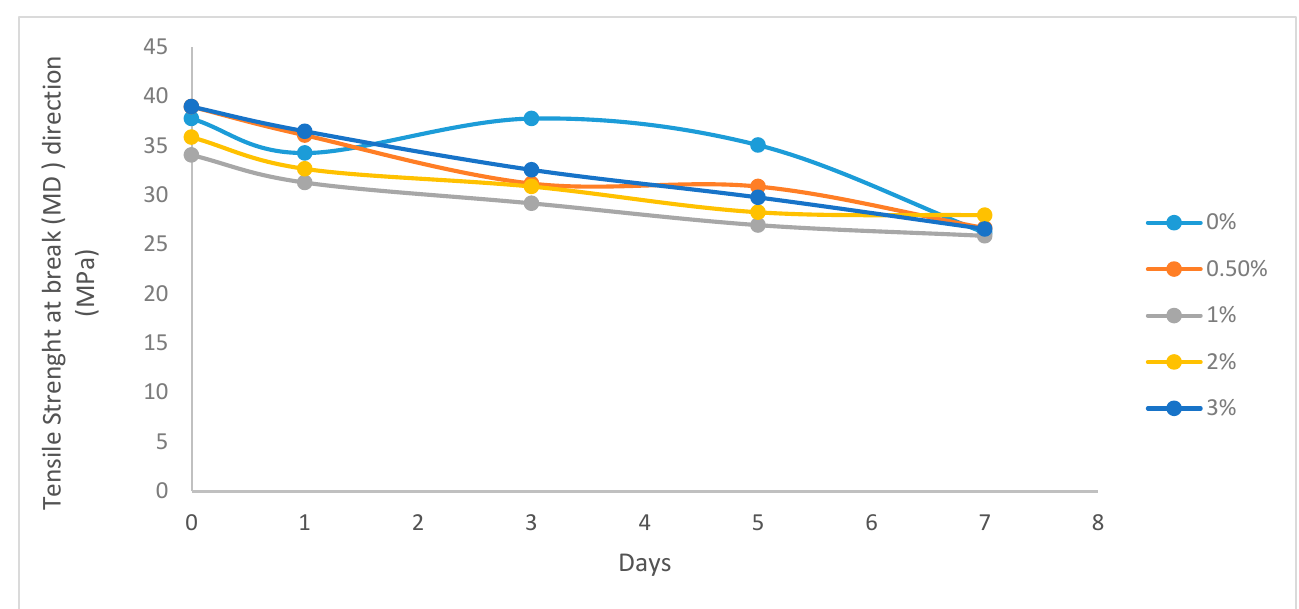
Figure 1. Changes in the tensile stress at break in machine direction (MD).